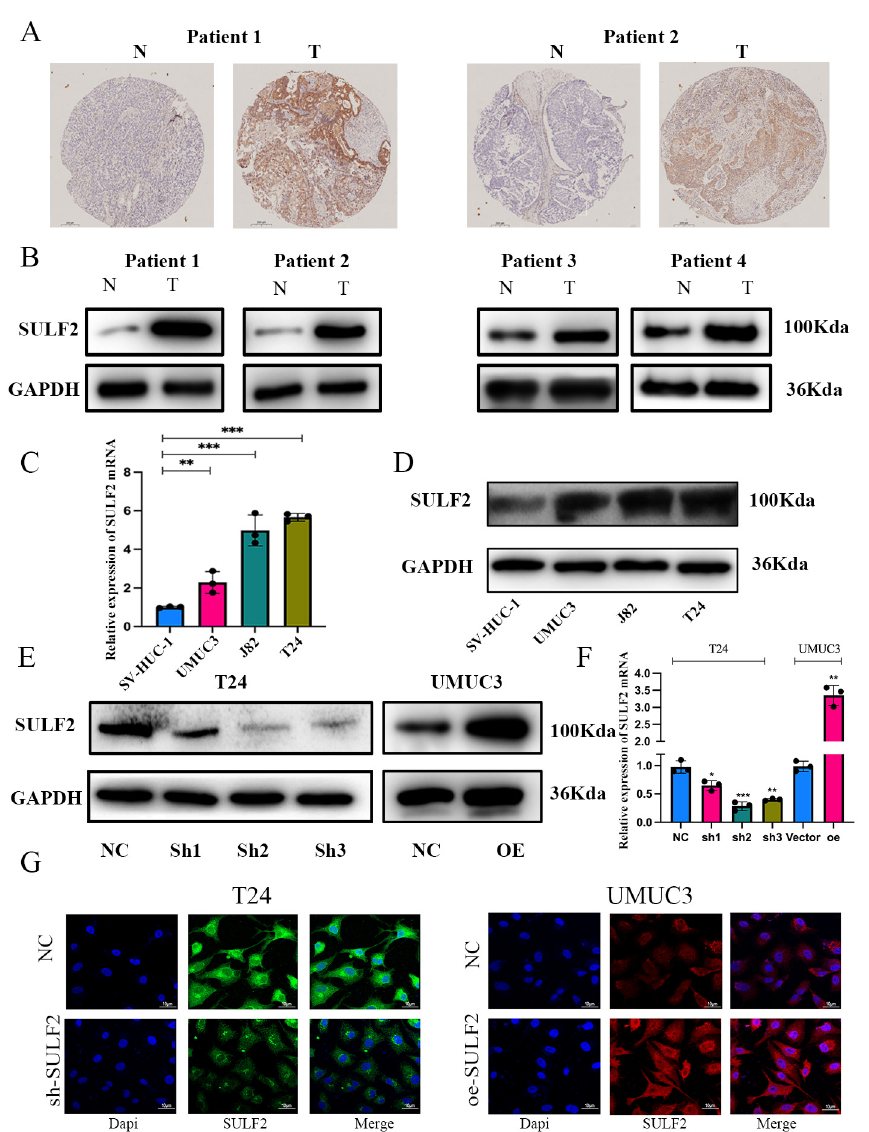
Figure 2. SULF2 is overexpressed in human BCa tissues and cell lines. ( A ) Representative images of SULF2 in BCa tissues (T) and adjacent normal tissues (N) by IHC staining. Scale bar = 200 µ m. ( B ) SULF2 expression in BCa tissues and adjacent normal tissues detected by western blot. ( C ) Relative mRNA and ( D ) protein levels of SULF2 in BCa cell lines and the immortalized human normal bladder epithelial cell line SV-HUC-1 detected by qPCR and western blot, respectively. ( E , F ) Knockdown and overexpression efficiencies of SULF2 were examined by qPCR and western blot, and GAPDH served as the internal control. ( G ) Immunofluorescence to verify the efficiency of knockdown and overexpression of SULF2. Data are represented as mean ± SD of three experiments. * p < 0.05, ** p < 0.01, *** p <